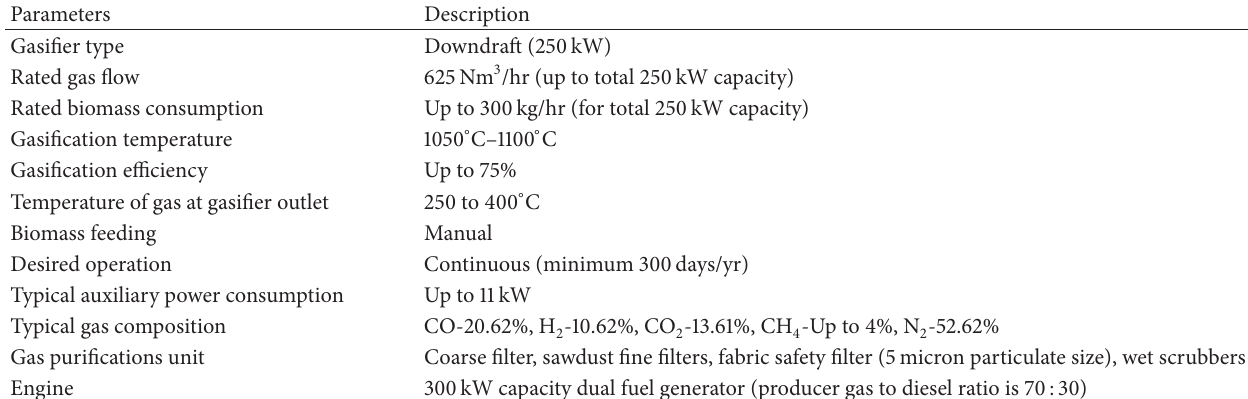
Table 7: Plant technical details [7].